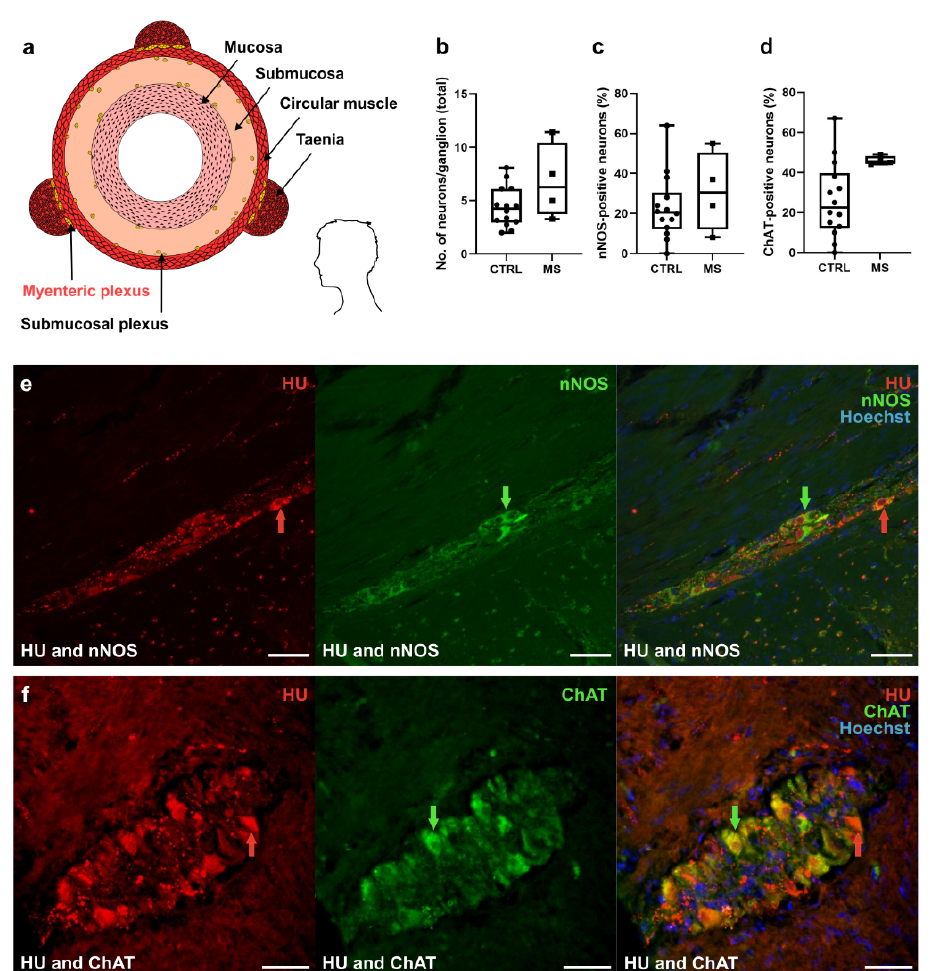
Figure 5. Immunohistological staining of the myenteric plexus (MP) of patients with multiple sclerosis (MS) ( n = 4) and non-MS controls (CTRLs) ( n = 14). ( a ) Paraffin-embedded human colon tissue was obtained from patients with MS and matched CTRLs. ( b ) Numbers of neurons per ganglion analyzed in each group. ( c , d ) Percentage of ( c ) neuronal nitric oxide synthase (nNOS) + and ( d ) choline acetyltransferase (ChAT) + neurons. Individual data points are patient mean values. The box and whisker plots show median values together with the interquartile range. For normally distributed data, statistical significance was determined by unpaired Student’s t test; otherwise, the Mann–Whitney U test was applied. ( e , f ) Representative images of the MP showing staining for ( e ) anti-HuC/D (HU) ( red arrow , first picture from the left) and nNOS ( green arrow , second picture from the left), combined with Hoechst 33258 (third picture from the left), and ( f ) HU ( red arrow , first picture from the left) and ChAT ( green arrow , second picture from the left), combined with Hoechst 33258 (third picture from the left). Scale bars denote 50 µ